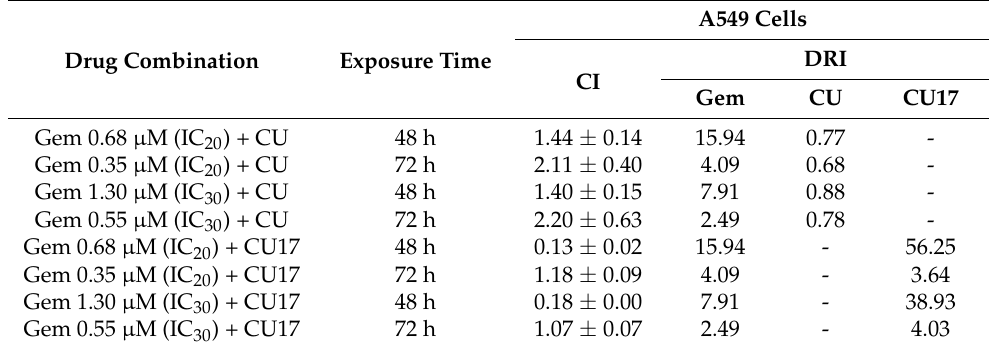
Table 2. Combination index (CI) and dose reduction index (DRI) of the combination treatments between gemcitabine (Gem) and CU or CU17 against A549